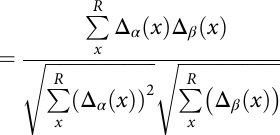
ffiffiffiffiffiffiffiffiffiffiffiffiffiffiffiffiffiffiffiffiffiffiffi P R